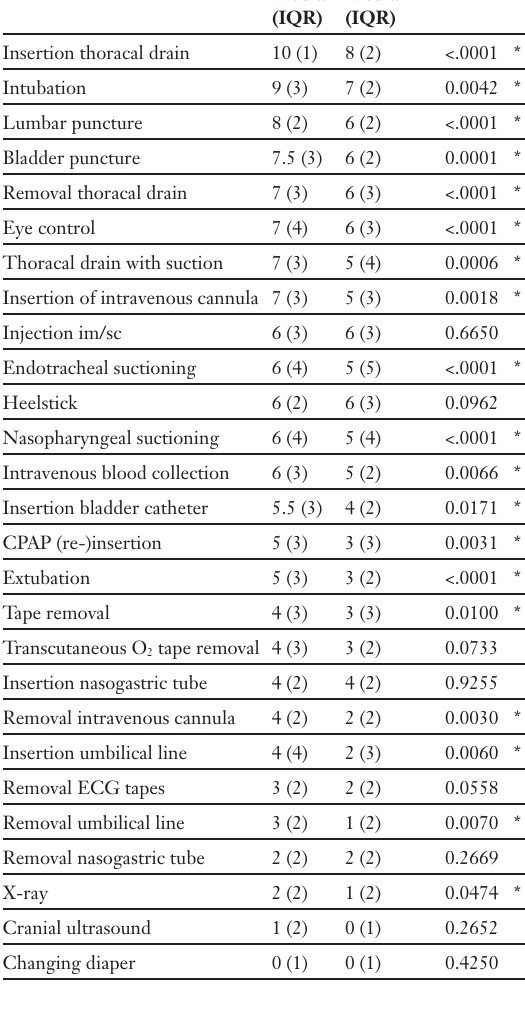
Table 3 Differences in the assessment of pain intensity between nurses and physi- cians.